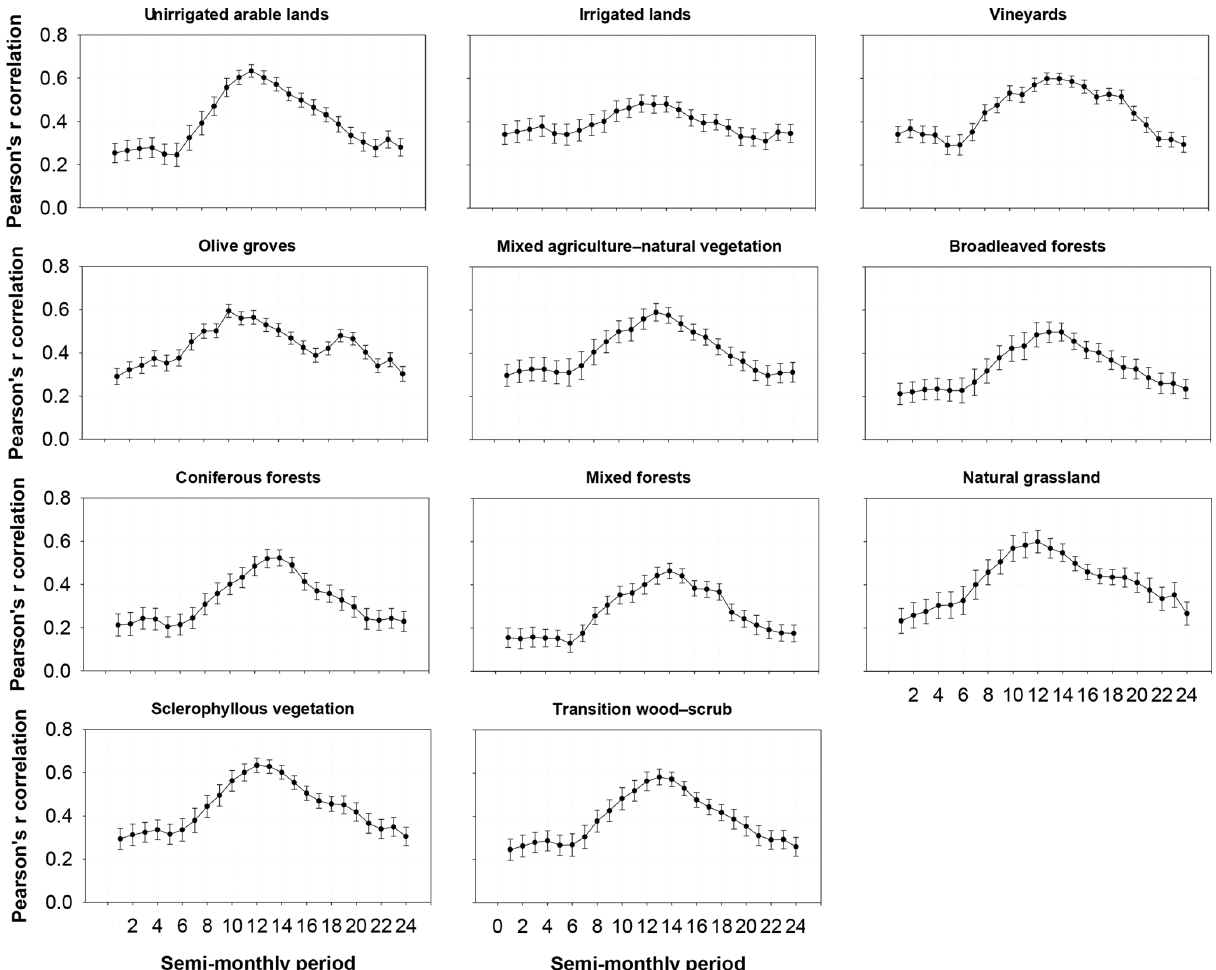
Figure 6. Average and standard error of the Pearson’s r correlation coefficient between the sNDVI and SPEI for the different land cover